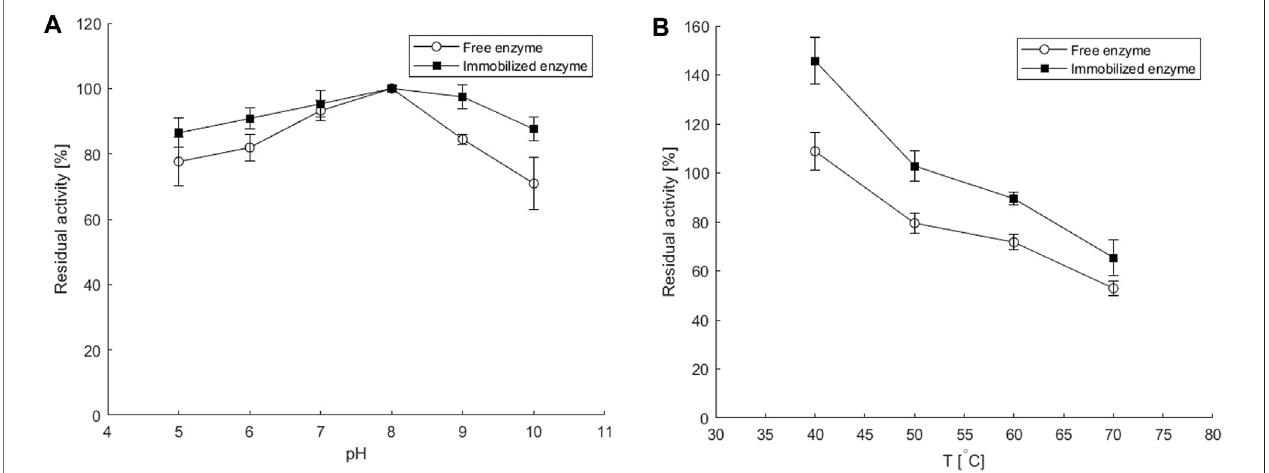
FIGURE 2 | Residual activities of the free and the immobilized enzyme as calculated from the batch enzyme activity assays performed before and after a 30-min incubationatvarious (A) pHvaluesand (B) temperaturesatconditionsspeci fi edin BatchEnzymeActivityMeasurement and EnzymeandCofactorCo-immobilizationina Copolymeric Hydrogel . Error bars indicate standard deviations of